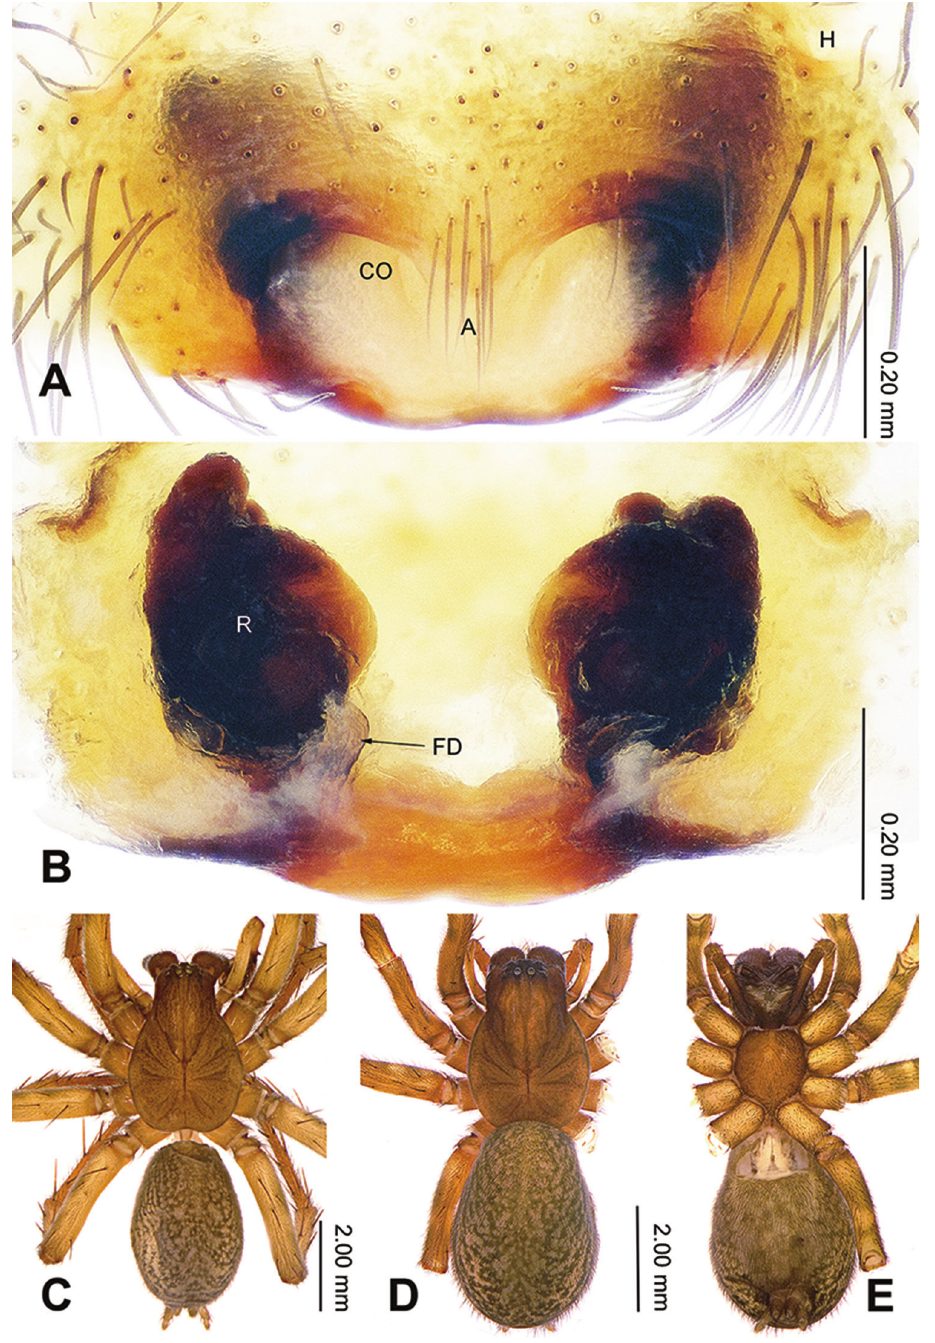
Figure 10. Epigyne and habitus of Sinodraconarius yui sp. n. A Epigyne, ventral B Vulva, dorsal C Male habitus, dorsal D Female habitus, dorsal E Female habitus, ventral. Scale bar equal for D and E